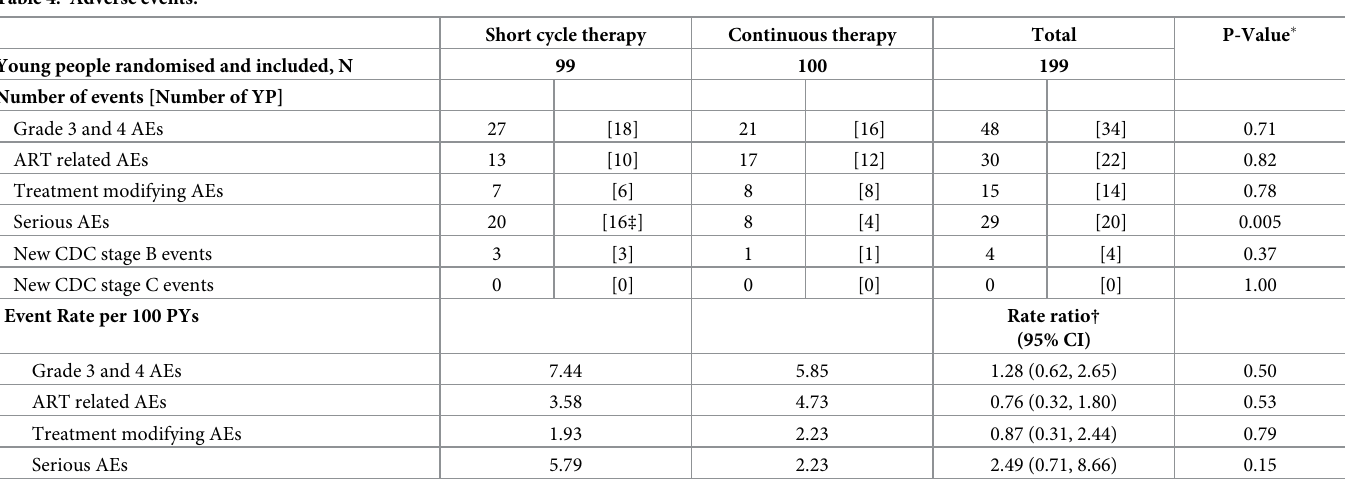
Table 4. Adverse